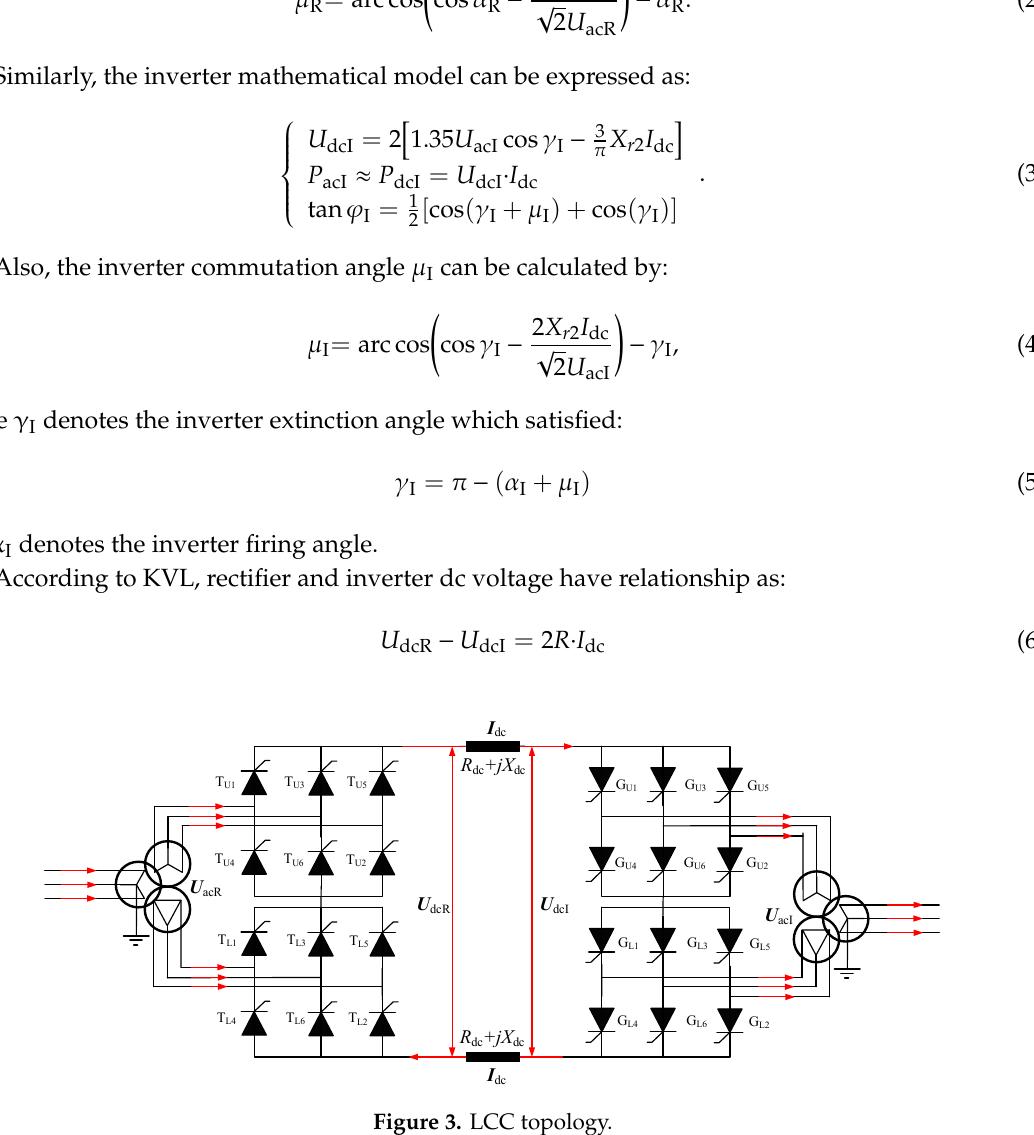
Figure 3. LCC Figure 3. LCC topology.